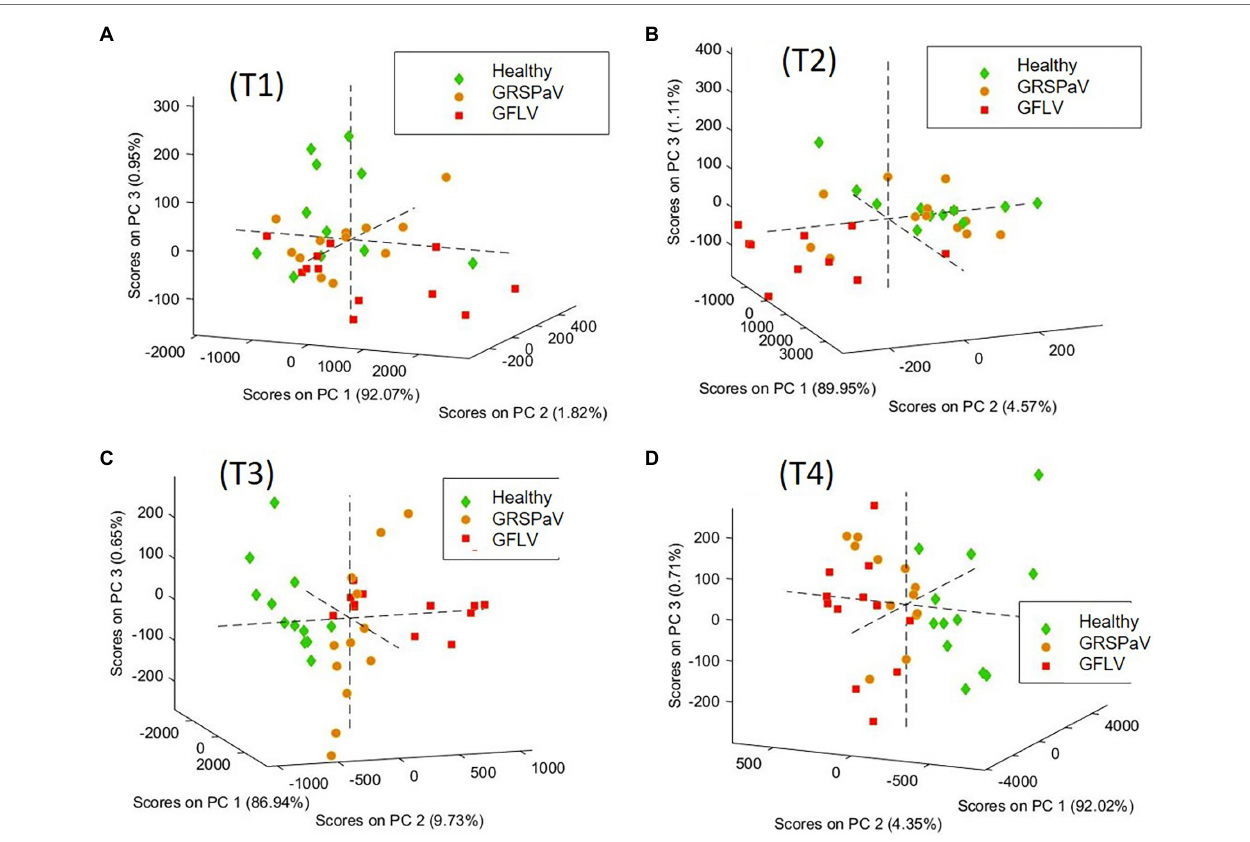
FIGURE 4 | PCA score plots of the spectra of healthy and GRSPaV- or GFLV-infected grapevine cv. Chardonnay plants, calculated at ( (A) T1, (B) T2, (C) T3, (D) T4, at monthly intervals). 3D graph rotation is set to optimize result